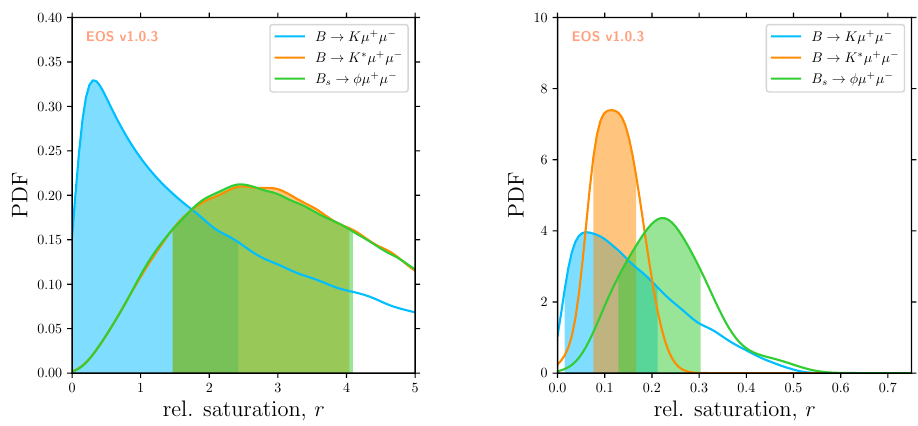
( r ) for the relative saturation r of the dispersive B ( r ) as defined in eq. (3.4), that is after applying B in the right-hand plot are due to s → φ